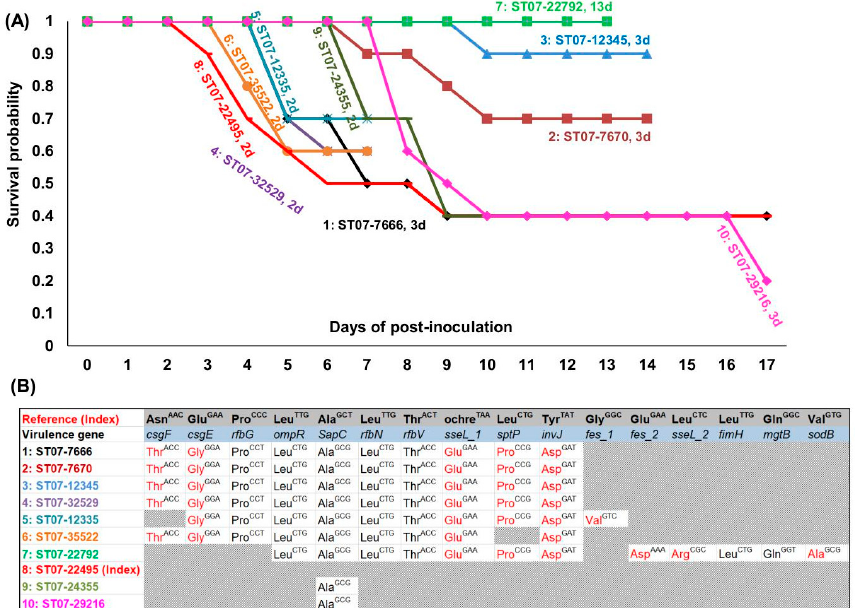
Figure 6. Survival rate plot of chickens inoculated with Salmonella Typhimurium strains and virulence gene variants detected among the strains, n = 10. ( A ) Survival rate plot of chicken inoculated with 10 S. Typhimurium strains. The sample name is labeled with ID: strain name, day post-infection when clinical signs were first observed, for instance, the number 1 sample was labeled as “1: ST07-7666, 3d”; the sample name was highlighted with the same color as its survival plot line color. The most virulent strain was ST07-22495 No. 8 strain (red color line with red short horizontal line highlighted) whereas the least virulent strain was No. 7 ST07-22792 strain (green color line with green square highlighted). ( B ) Detected variants among the 10 S. Typhimurium strains used for the infection experiment, using No. 8_ST07-22495 as index. For easy identity, the same color was used for strain names as well in panel ( A ). The variants causing non-synonymous amino acid changes are highlighted in red.